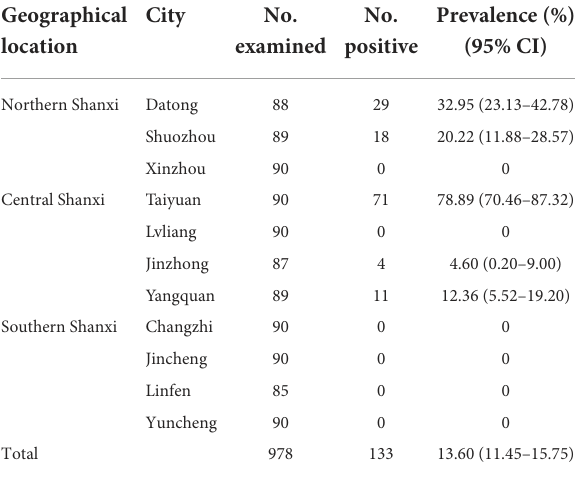
TABLE 1 The seroprevalence of N. caninum in cattle in different cities of Shanxi